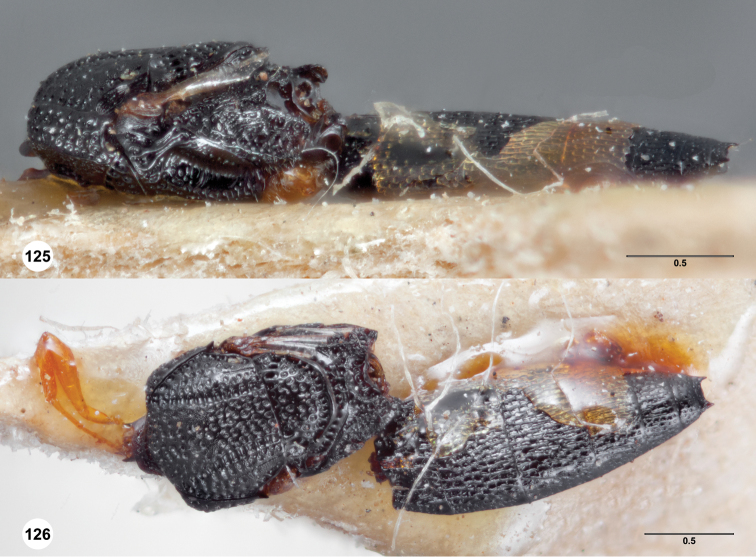
Oxyscelio grandis (Dodd), holotype male (SAMA DB 32-001588) 125 Mesosoma and metasoma, lateral view 126 Mesosoma and metasoma, dorsal view. Morphbank51